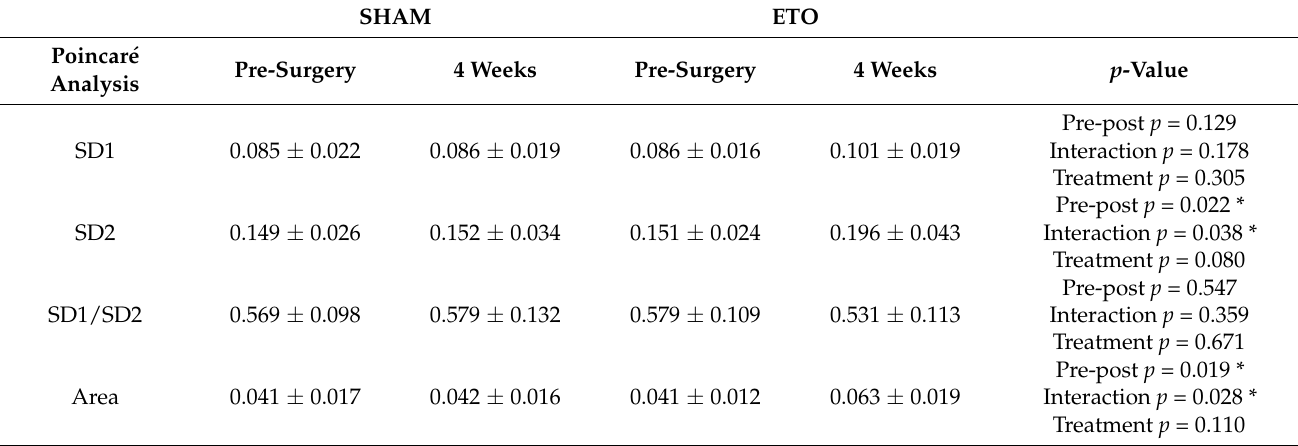
Table 1. Poincar é analysis of breath cycle period variability between ETO-treated rats and SHAM controls. Standard deviation (SD1, SD2) calculated for each rat defines two axes an ellipse fitted to the dataset. Values are expressed as mean ± SD. Statistical significance (*) indicates p < 0.05 for Bonferroni post hoc